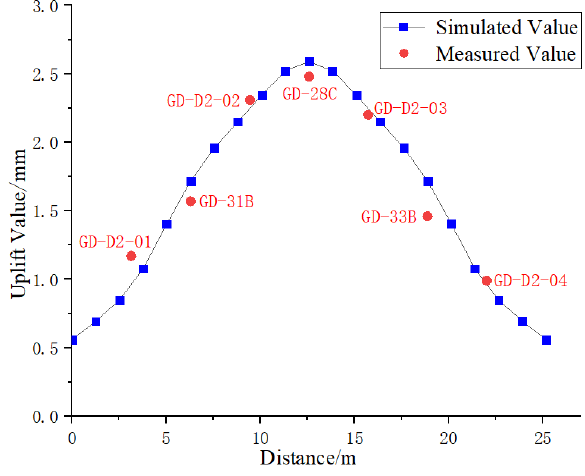
Figure 20. Comparison diagram of uplift value of station top plate.